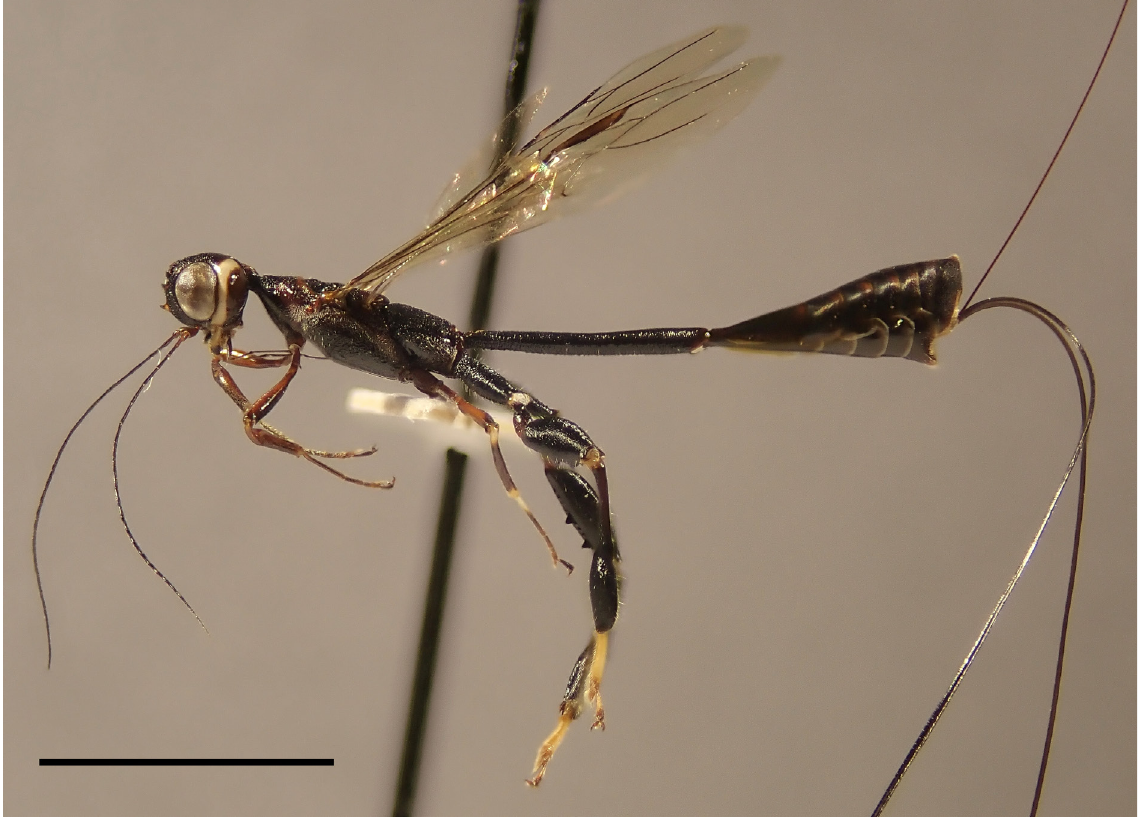
Fig. 11. Parastephanus mouensis Aguiar, 2005 (MNHN). Lateral habitus. Scale bar =